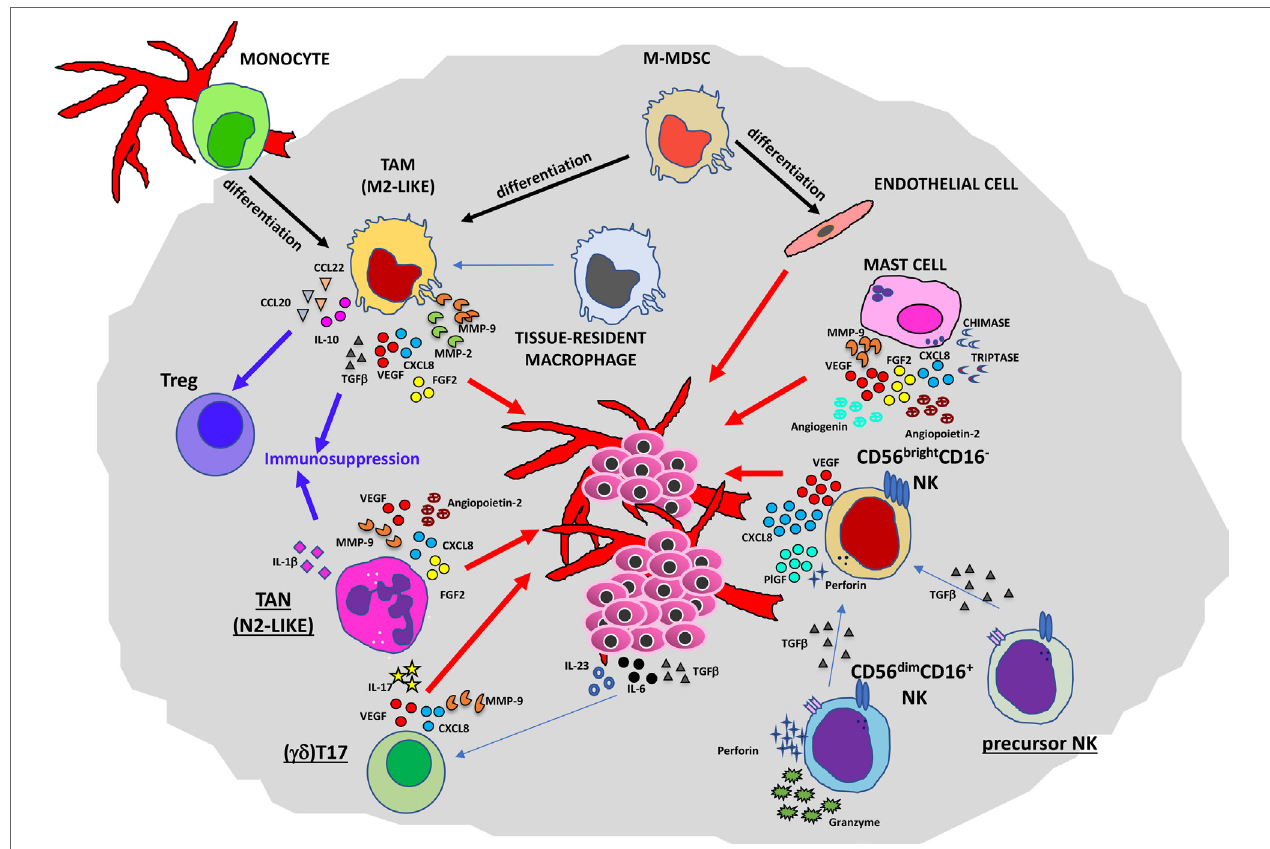
FigURe 2 | Contribution of innate immunity to tumor angiogenesis. Soluble mediators (chemokines, cytokines, and enzymes) within the tumor microenvironment act directly or indirectly as proangiogenic factors produced by macrophages [M2-like tumor-associated macrophages (TAMs)], neutrophils [tumor-associated neutrophil (TAN), N2-like], myeloid-derived-suppressor cells (MDSCs), mast cells, and natural killer (NK)